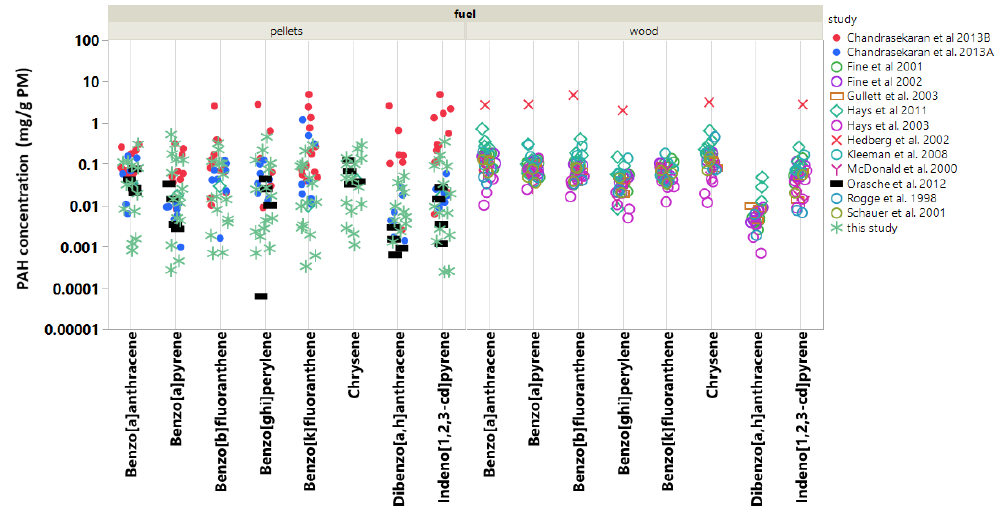
Figure 4. Comparison of PAH concentrations in PM (mg/g PM) emitted from wood- and pellet-burning appliances. Data populations for individual compounds ranged from n = 57 to n = 92. Figure S5 shows the calculated means with standard error and median values for individual PAH concentrations gathered across the multiple studies. These values are provided in an effort to highlight differences and provide